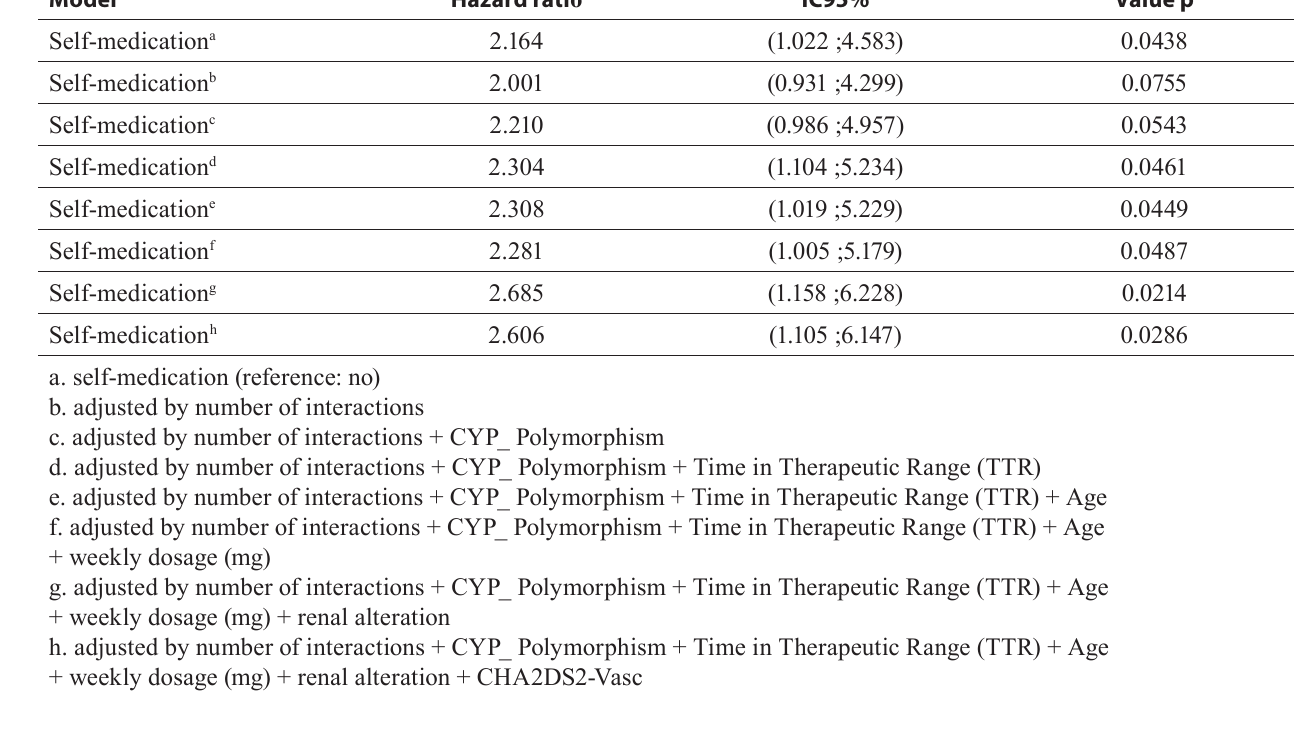
TABLE II - Association between bleeding and self-medication among patients taking warfarin in a cohort of patients from the city of Ijuí/Brazil n=68 Hazard ratio self-measurement in relation to the occurrence of bleeding.